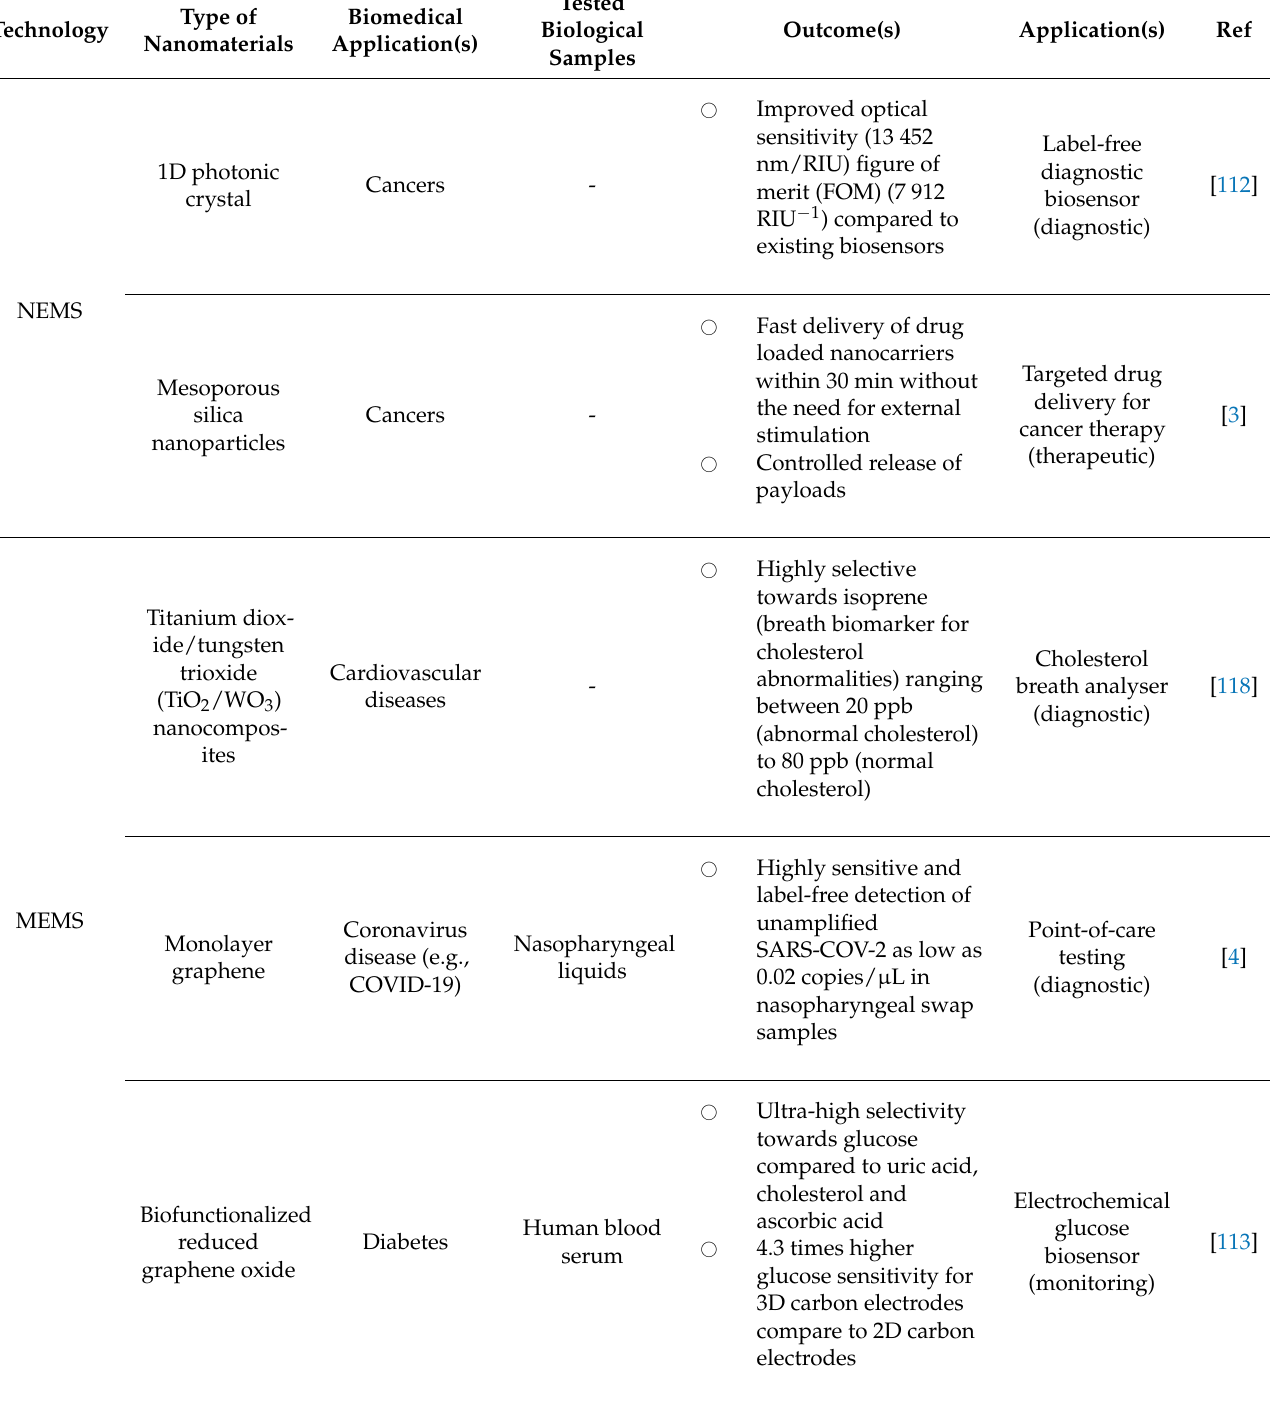
Table 2. Example studies on nanomaterials-based bioNEMS/MEMS for diagnostic, monitoring and therapeutic applications (selected studies between